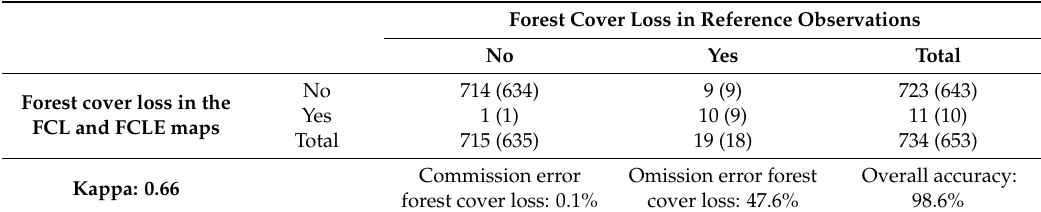
Table 1. Confusion matrix based on the reference observations. Plain values show the results of the whole data set; the data used for post-stratification are in